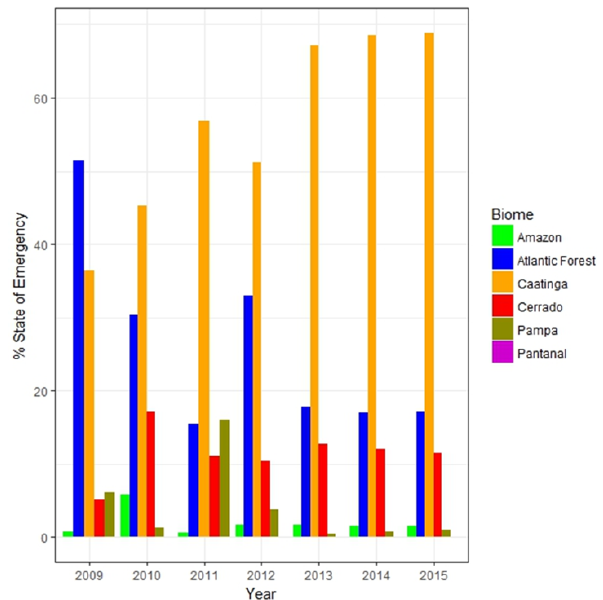
Figure 2. Percentage of municipalities declaring emergency or pub- lic calamity due to drought in Brazil from 2009 to